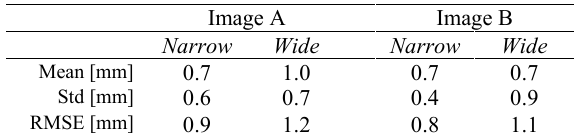
Table 2 . Statistics of the differences between the estimated crack width, respectively from image A and image B, with manual measurements obtained from the reference photogrammetric point cloud on the same